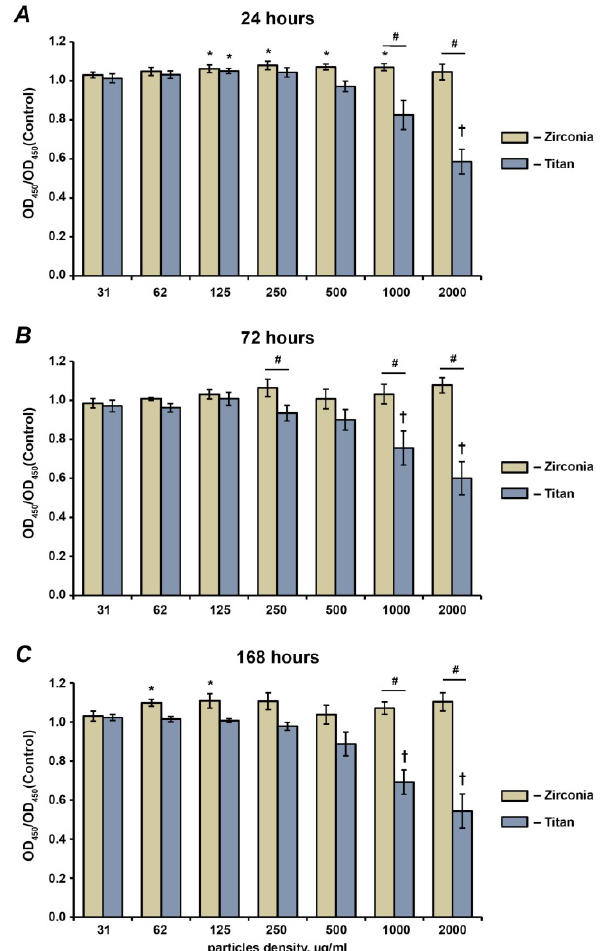
Figure 1. Effect of different NPs on the proliferation and viability of hG-MSCs. The hG-MSCs were cultured in the absence or in the presence of titanium or zirconia NPs at different concentrations for 24 h (A), 72 h (B), or 168 h (C). The proliferation and viability were measured using the MTT method. The Y-axis represents the ratios of optical densities (OD) measured at 570 nm in hG-MSCs cultured with NPs to those in the control group (without NPs). Data are presented as means ± s.e.m. of six independent experiments with hG-MSCs isolated from six different donors. Note: *— significantly higher compared to control, p < 0.05; †—significantly lower compared to control, p < 0.05; #—significantly different between Ti NPs and Zr NPs, p < 0.05.